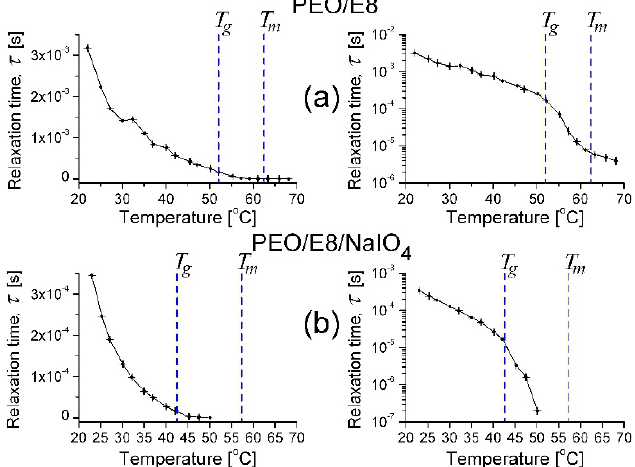
Figure 5. Characteristic dielectric relaxation times τ calculated for PEO/E8 ( a ) and PEO/E8/NaIO 4 ( b ). The dashed lines point out the values of glass transition temperatures ( T g ) and melting temper- atures ( T m ) for both composites. The error bars represent the uncertainty limits for the measured data. The relative error by evaluation of τ is: δ τ / τ = ± δ f/f , where δ f = 0.1 Hz is the accuracy of the measured values of the frequency f .